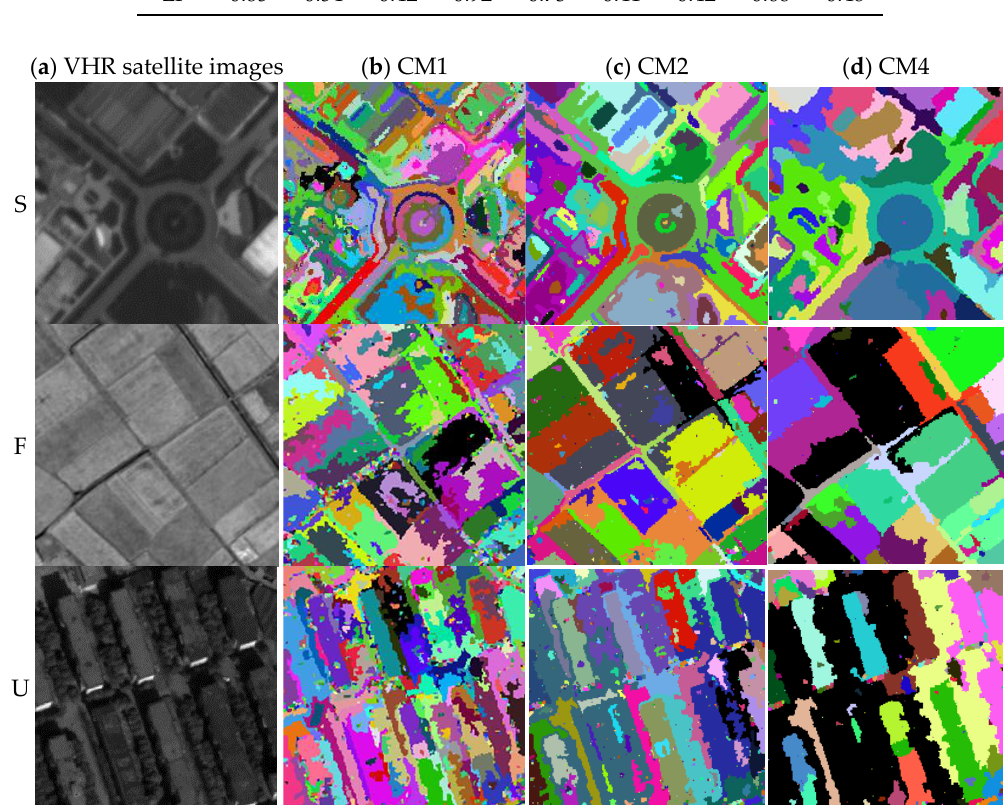
Figure 4. Over-segmentation of Very High Resolution (VHR) satellite images using the ddCRP with different connection modes: ( a ) VHR satellite images of three kinds of scenes, i.e., Suburb (S), Farmland (F), and Urban (U) areas, and corresponding over-segmentations using the ddCRP with ( b ) one-connection mode (CM1), ( c ) the two-connection mode (CM2), and ( d ) the four-connection mode (CM4),